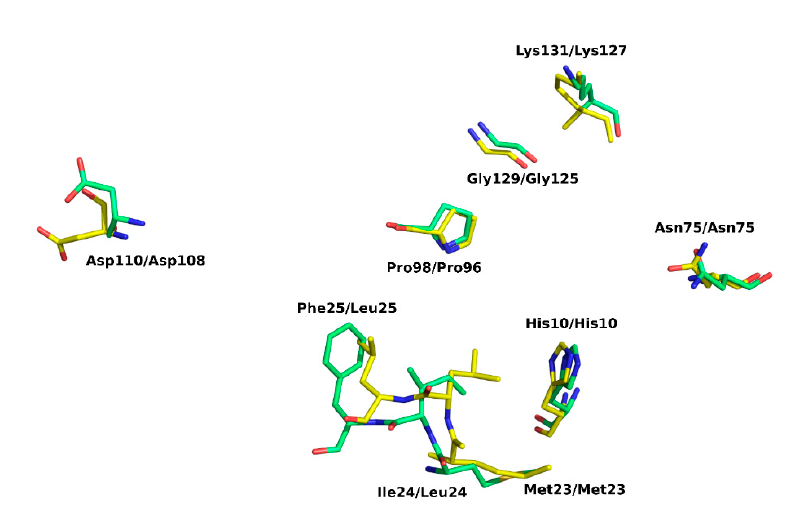
Figure 8. Comparison of the active site architecture of SpEIIA-Man (green) and EcEIIA-Man (yellow). Key amino acids are shown in a stick representation. Side chain nitrogens and oxygens are displayed in blue and red, respectively.